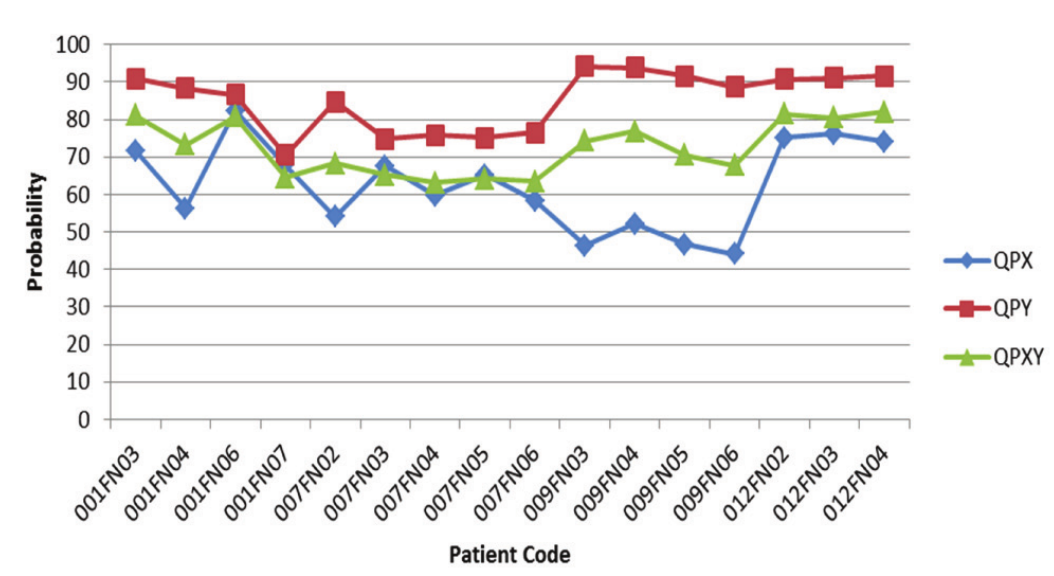
Figure 7. Kinematic QPs. Results for axis x, y and xy combined. Note the better results from channel y.